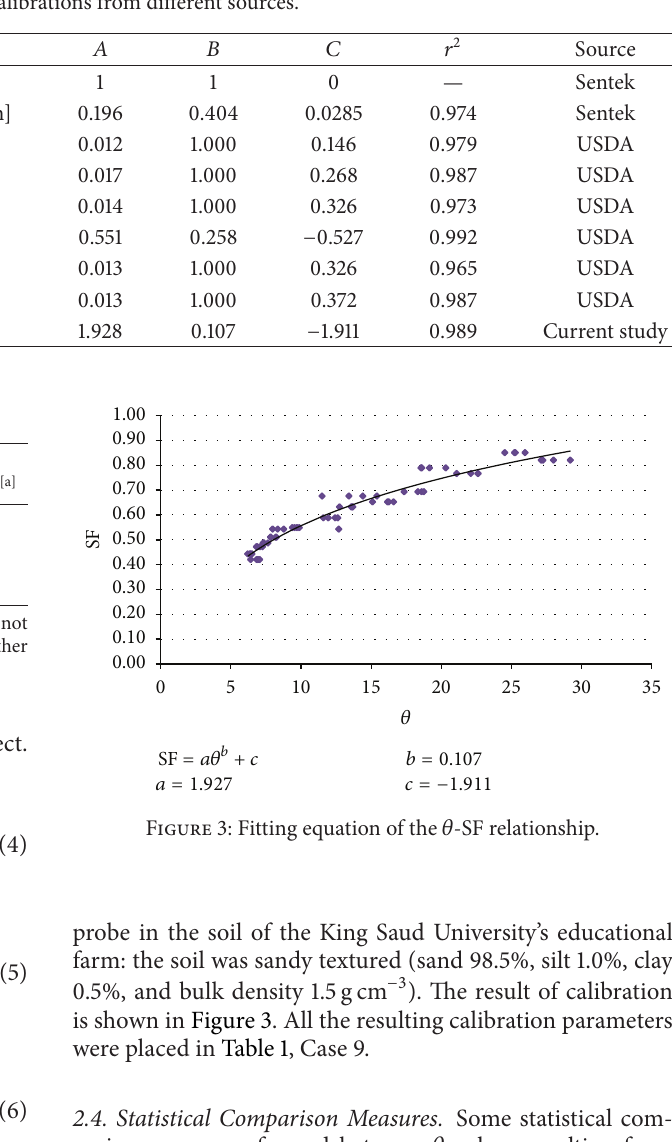
Table 1: Sample soil calibrations from different sources.